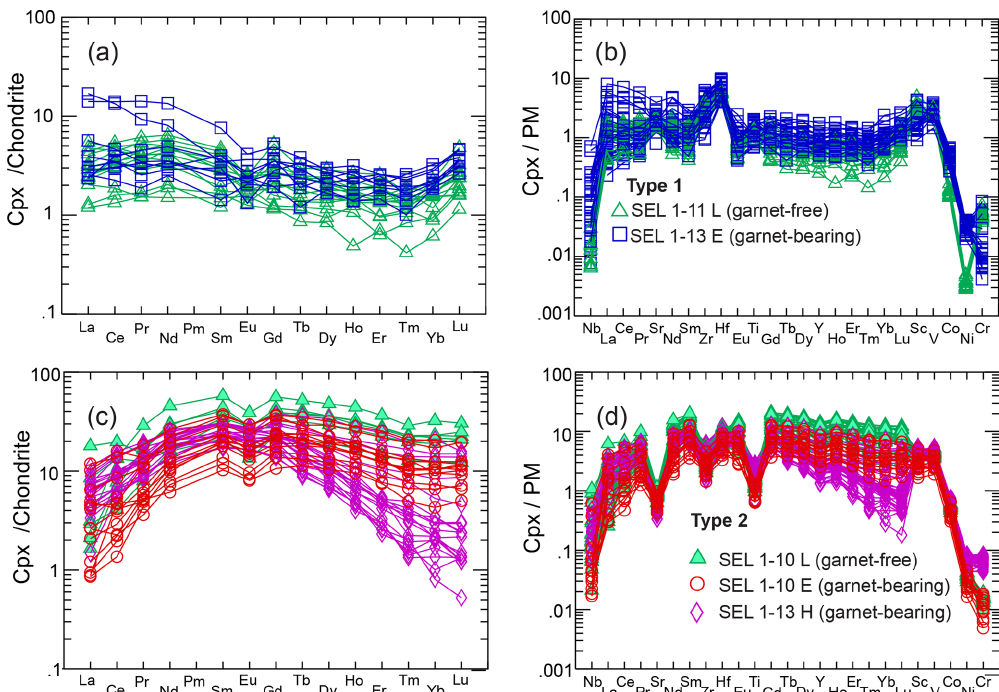
Figure 4. Chondrite-normalised rare earth element and primitive mantle normalised incompatible element patterns for clinopyroxene. Nor- malisation factors from Sun and McDonough (1989). (a) Chondrite-normalised rare earth element plot of type 1 clinopyroxene. (b) Primitive mantle-normalised multi-element plot type 1 clinopyroxene. (c) Chondrite-normalised rare earth element plot type 2 clinopyroxene. (d) Prim- itive mantle-normalised multi-element plot of type 2